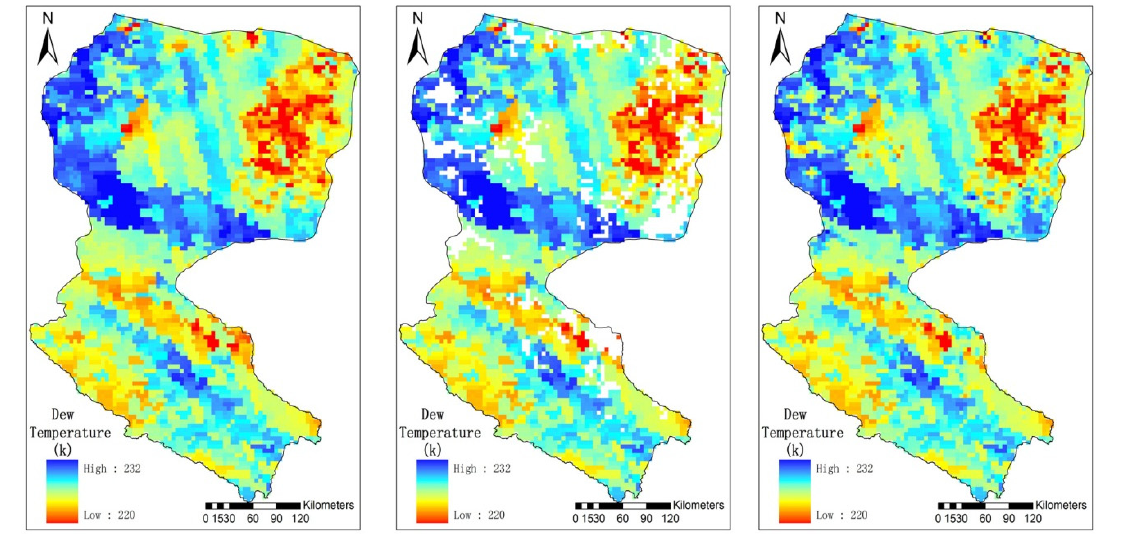
Figure 6. The validation of moisture data for the Heihe river basin at 700 hPa: original data, screening area and data after gap filling for 25 March